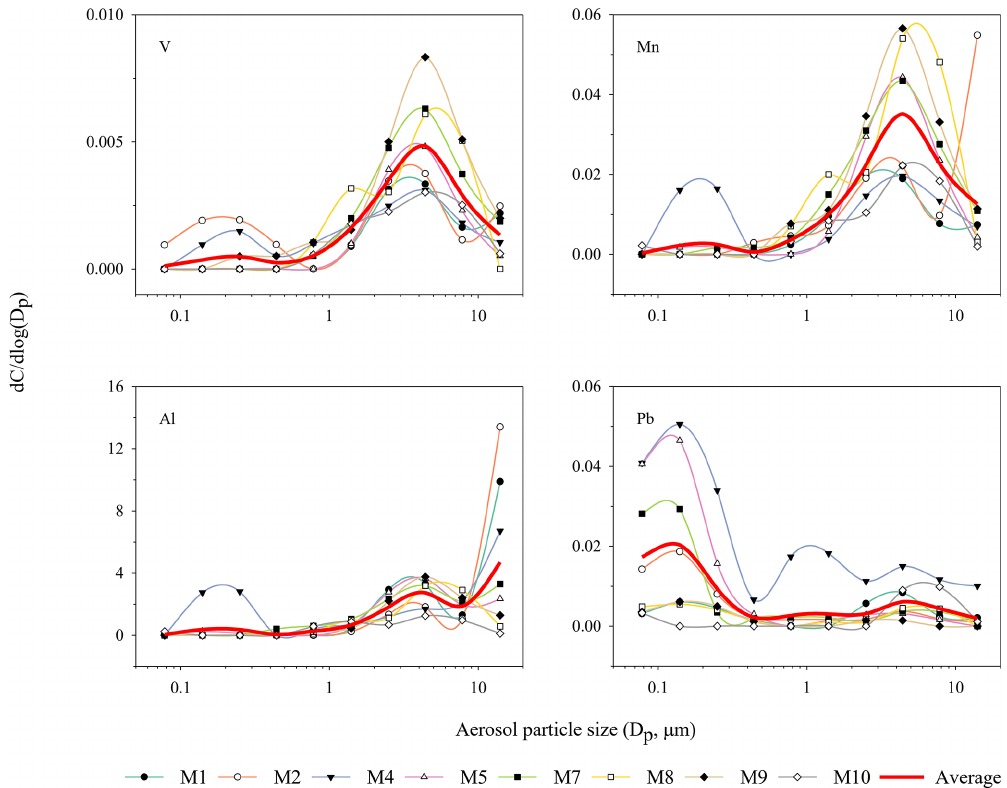
Figure 8. Particle-size distributions of the trace elements showing bimodal and trimodal distribution in aerosols during November 2016– January 2017 austral summer over Palmer Station. d C/ dlog (D p ) is the normalized